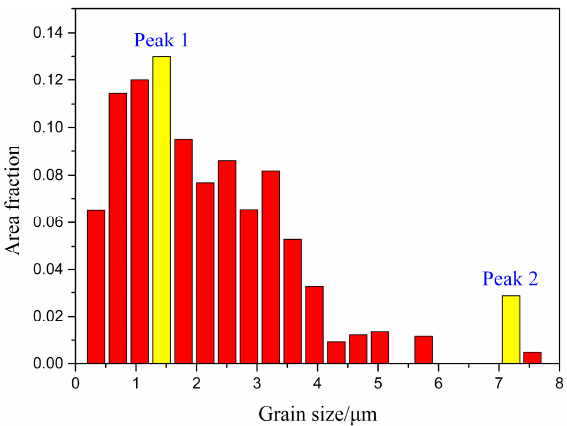
Figure 7. Grain size distribution of the fusion zone in the heat-treated joint (P = 2500 W, t = 5 ms).